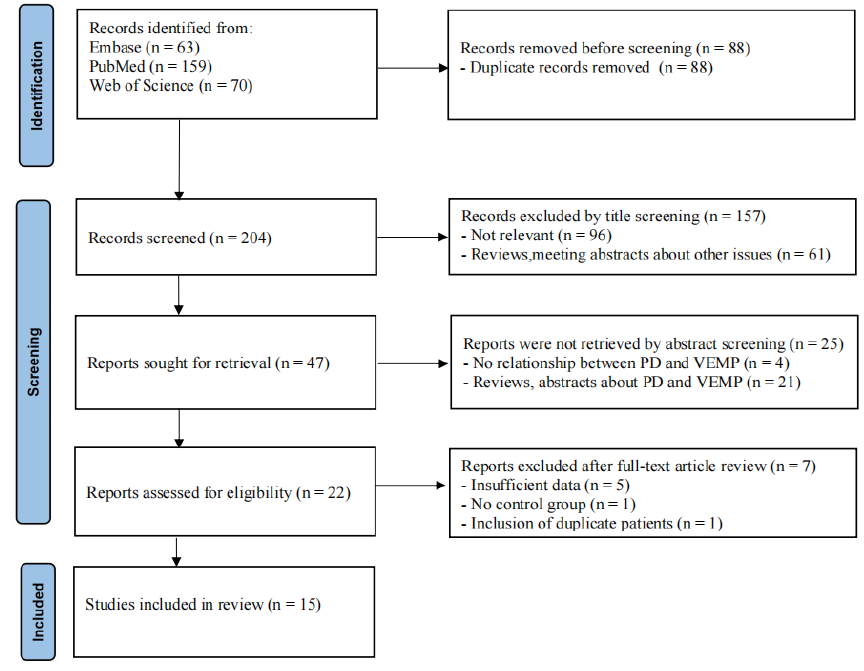
Figure 1. Flowchart of search strategy and study selection.